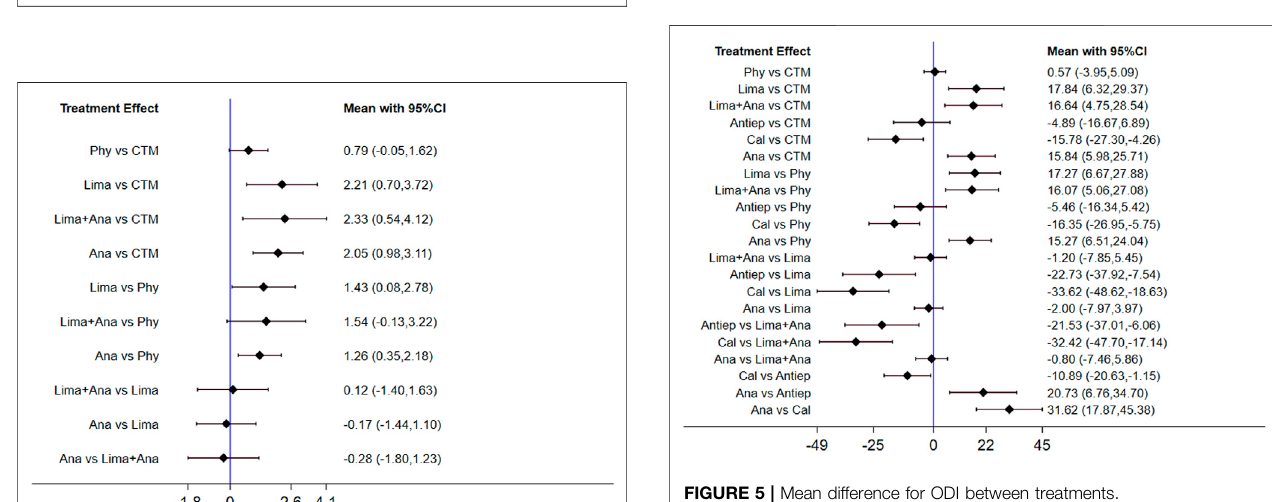
FIGURE 2 | Network plot for included studies on VAS.